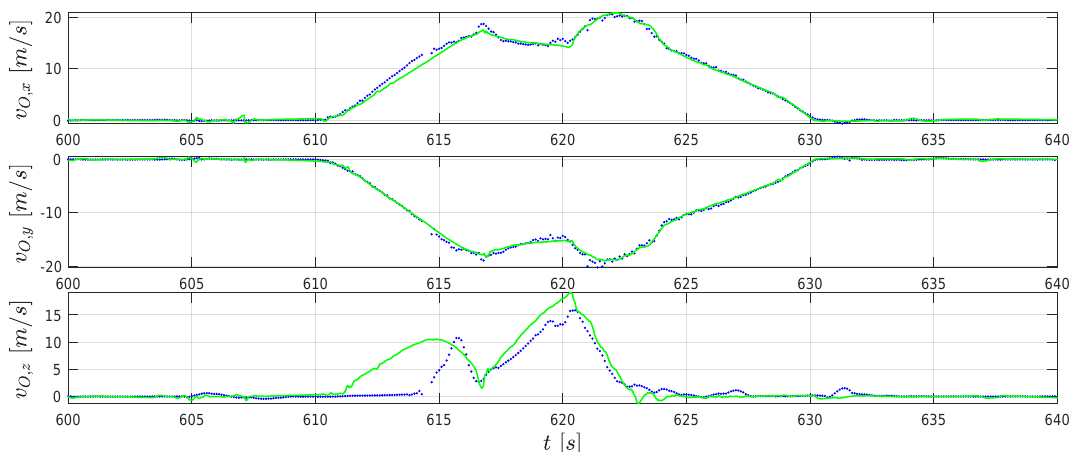
Figure 9. GPS velocity measurements v O, GPS (blue dots) and the extended RTS smoother reconstructed velocity v O (green line).